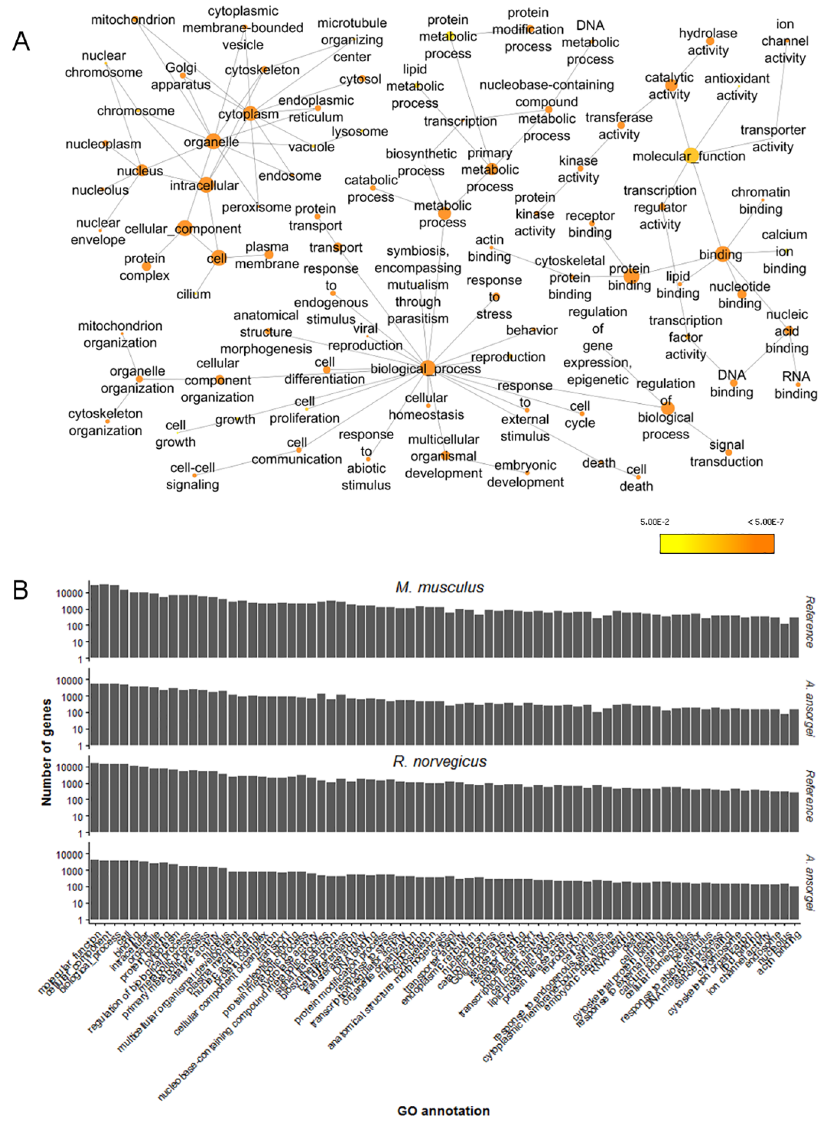
Fig 4. Enrichment analysis of Gene Ontology annotations. A) Enrichment of GOSlim annotations in the molecularfunction, cellularcomponent,and molecularprocess subgroups. Nodes are enrichedGO annotations, and their sizes are proportional to the numberof geneswith which they are associated.Color scale indicatesBenjamin-HochbergFalse DiscoveryRate (FDR) corrected p-value from hypergeometric test for enrichment. B) Number of genescorrespondingto GOSlim annotations with greater than 2% coveragefor A . ansorgei as comparedto both M . musculus and R . norvegicus